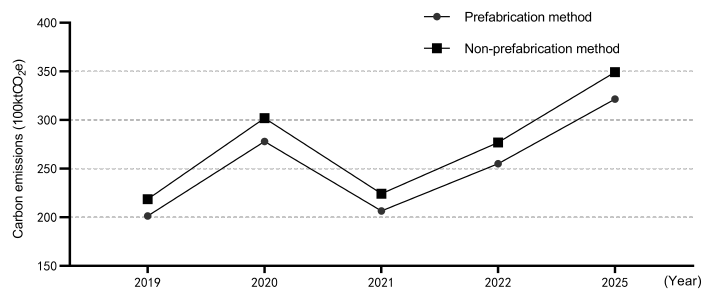
Figure 12. Schematic diagram of carbon emissions reduction in the production and construction stages of newly built prefabricated buildings in Zhejiang